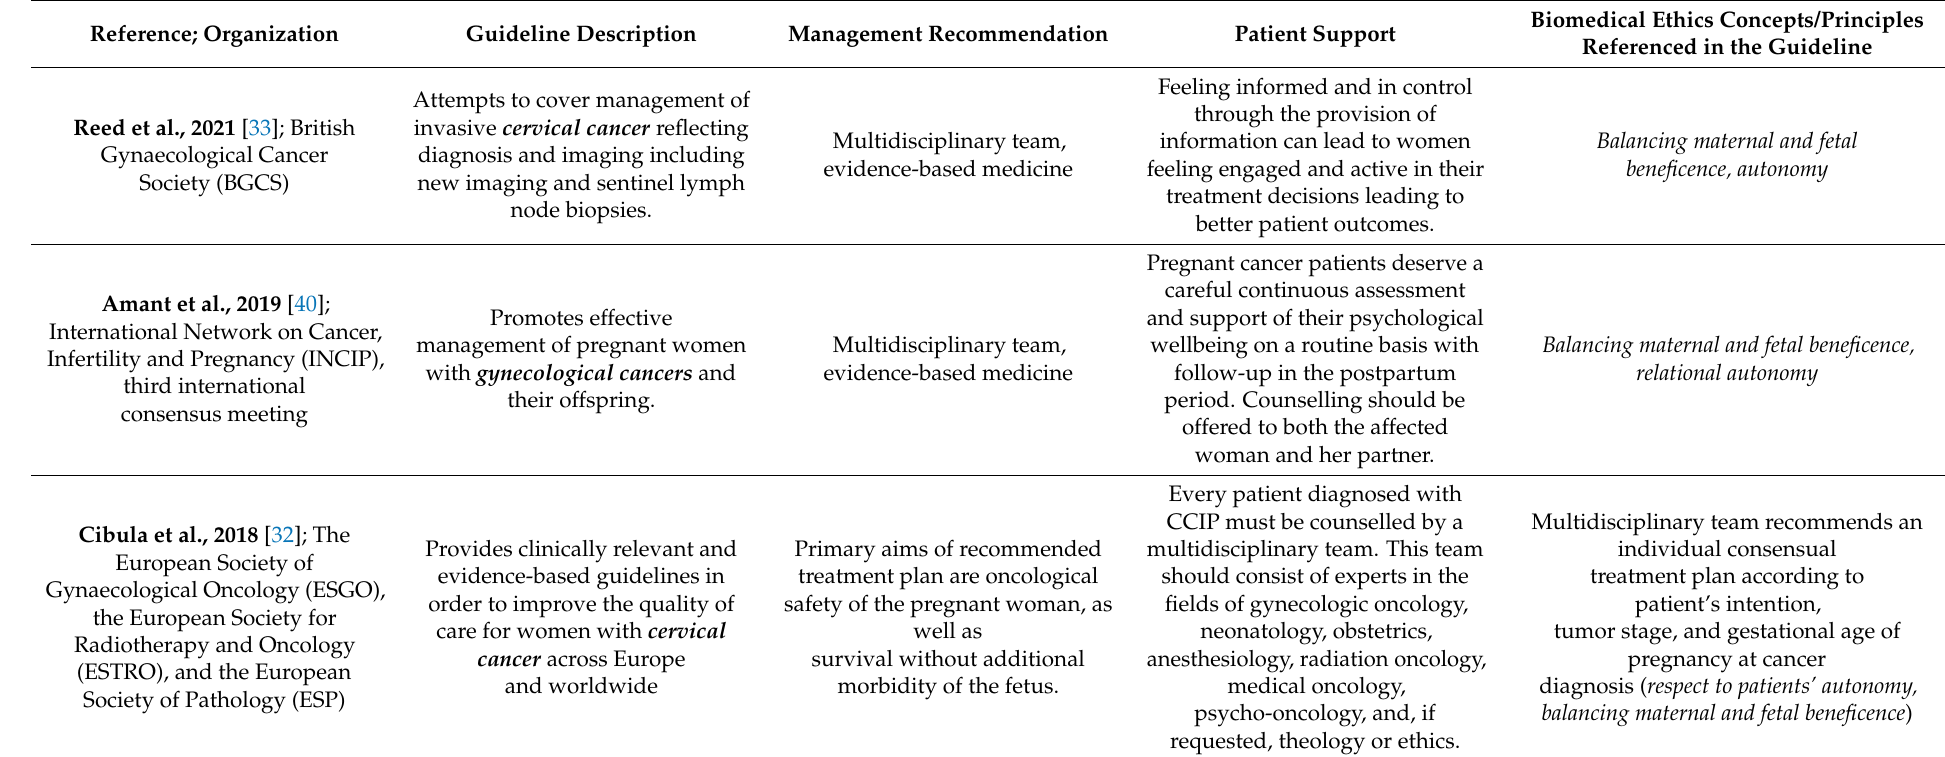
Table 2. Review summary and key findings of clinical practice guidelines addressing cancer management during